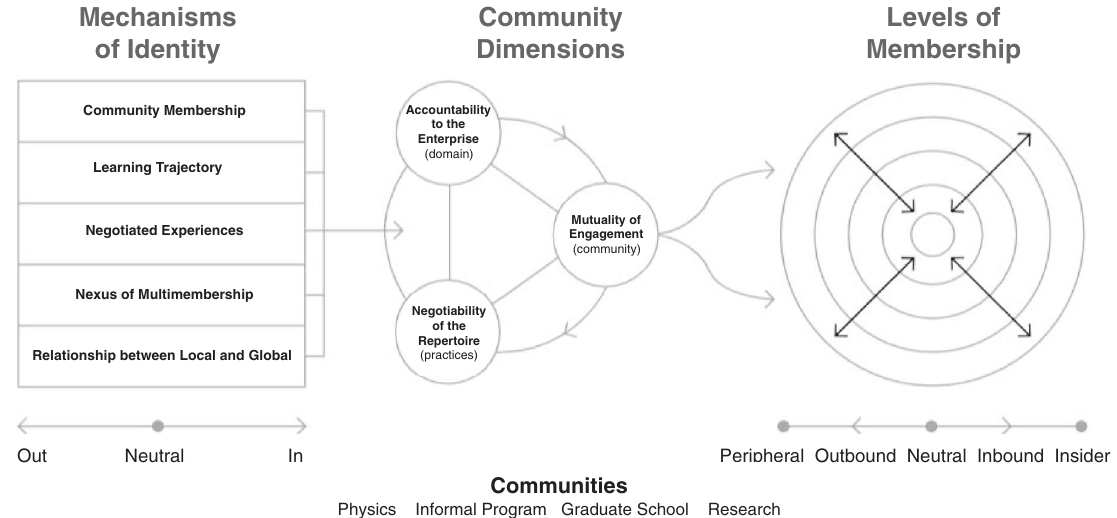
FIG. 1. The three essential elements of a community of practice (shown in the middle column) contain the domain, community, and practice and must all be identifiable within a community in order to use the communities of practice framework. The mechanisms of identity (first column) interact with the elements of the community of practice and influence individuals ’ membership levels (shown in the third